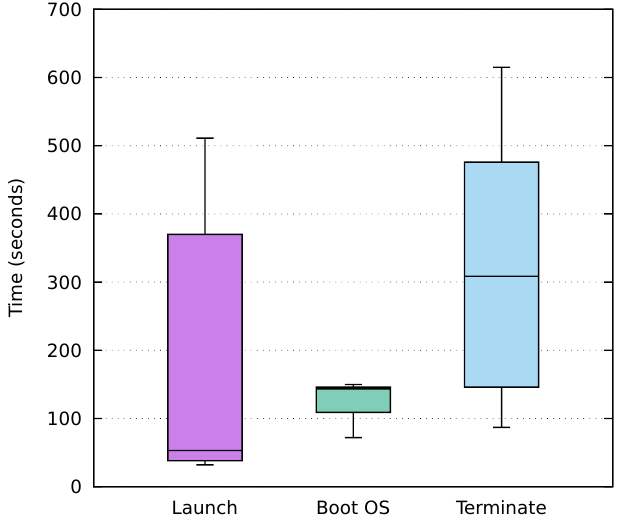
Figure 7. Launch, boot OS and terminate time of instances on AWS